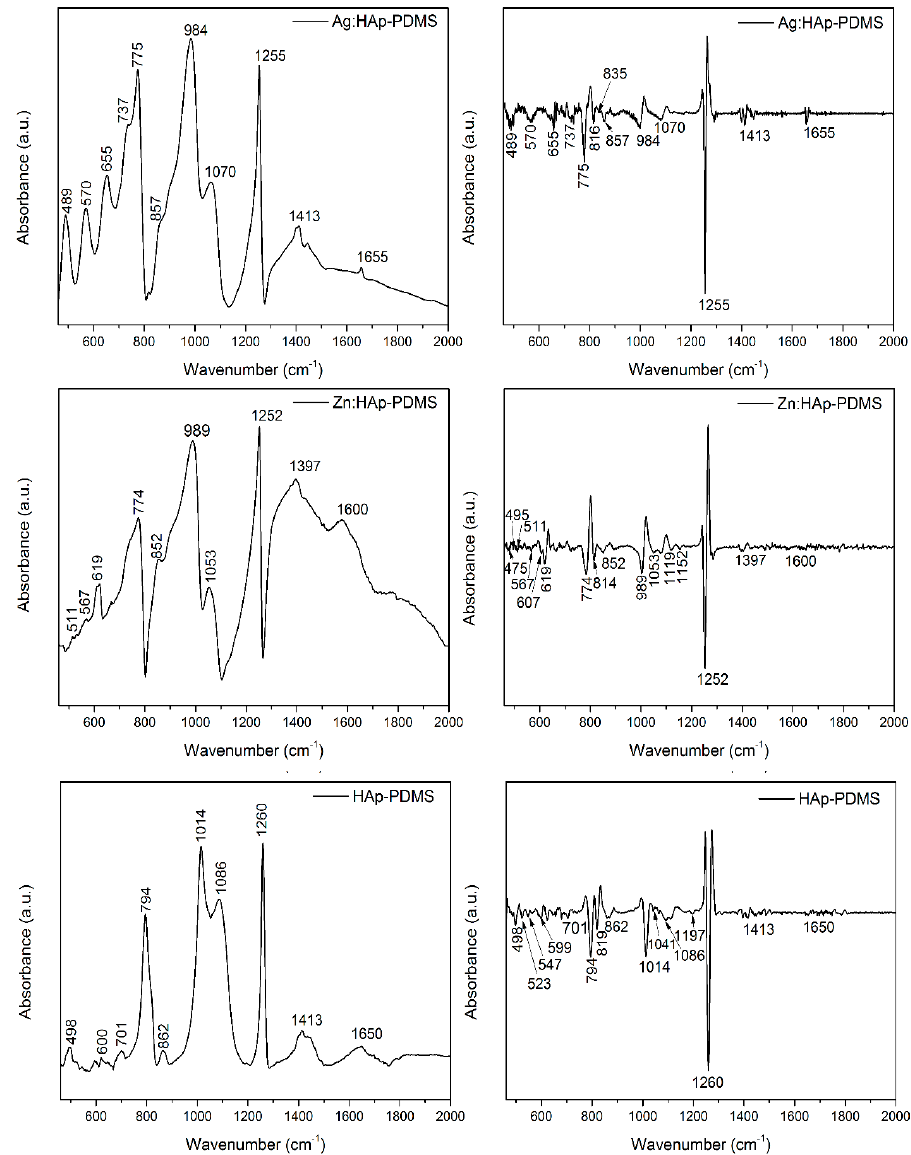
Figure 8. FTIR spectra and second derivatives of the HAp-PDMS, Ag:HAp-PDMS and Zn:HAp-PDMS composite layers.